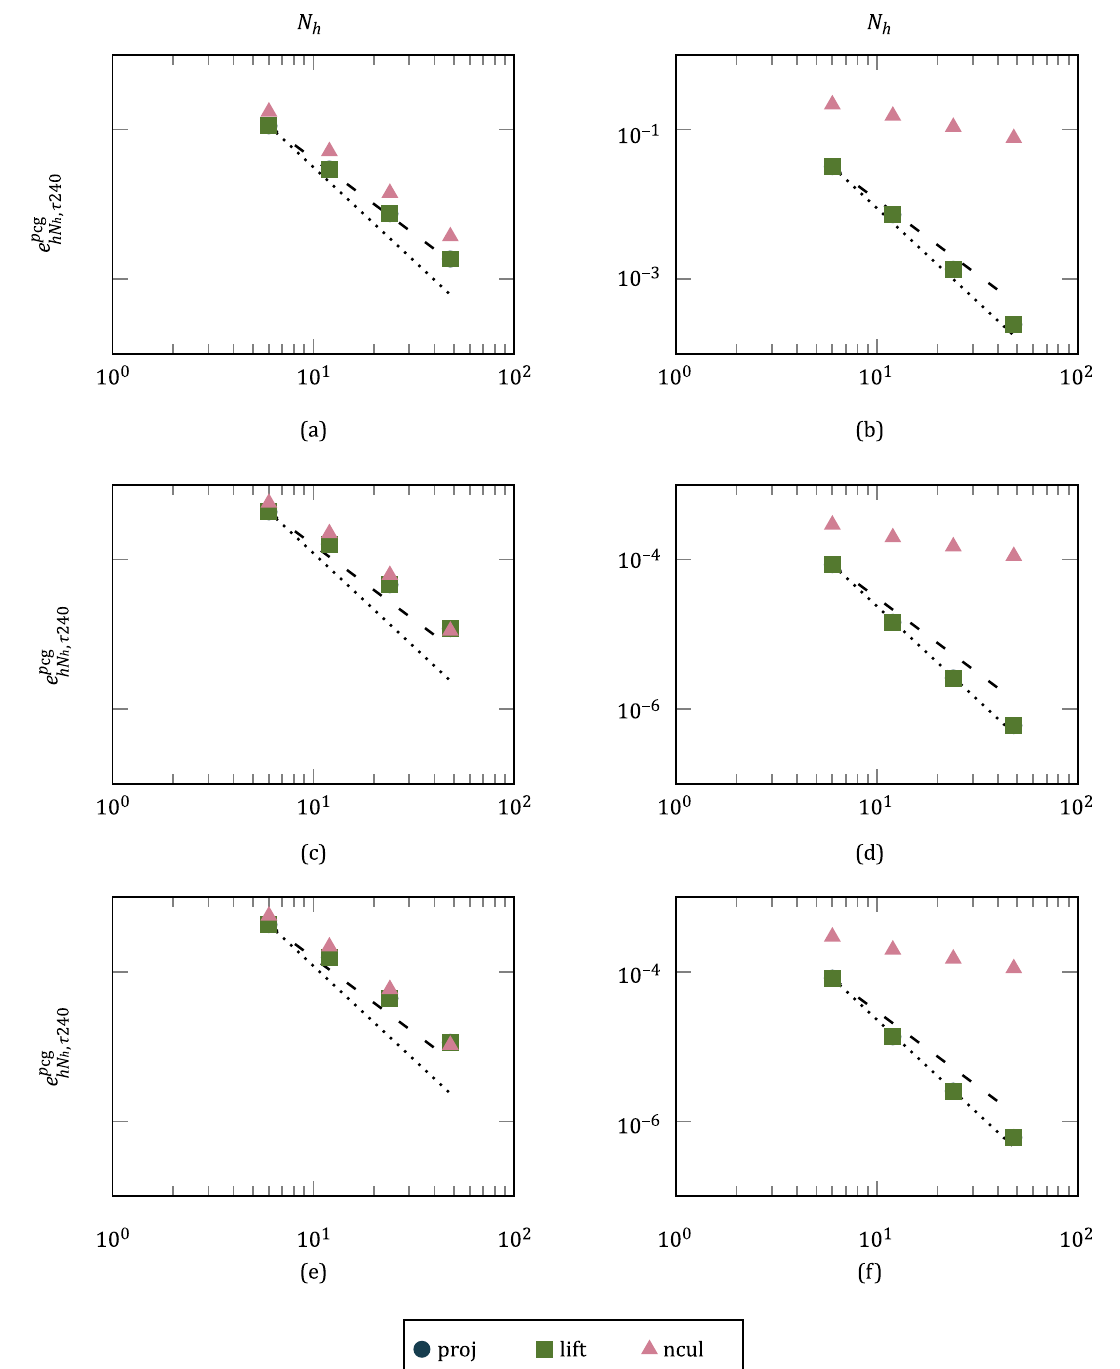
Figure 3. Convergence tests for the consistent implementations, cf. the section Convergence tests . The error e pcg space discretizations N h and for linear (left) and quadratic (right) shape functions. The fi rst row of plots (a and b) corresponds to Test Case 1, the middle row (c and d) to Test Case 2, and the bottom line (e and f) to Test Case 3. The dashed lines indicate the slope of a quadratic convergence the dotted lines indicate a convergence of order